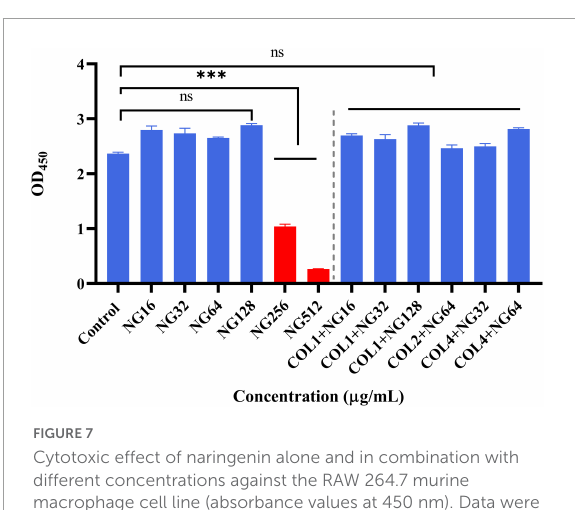
FIGURE7 Cytotoxic effect of naringenin alone and in combination with different concentrations against the RAW 264.7 murine macrophage cell line (absorbance values at 450 nm). Data were analyzed by Student’s t -test; ns, not statistically significant; *** P < 0.001. Naringenin (NG) and colistin